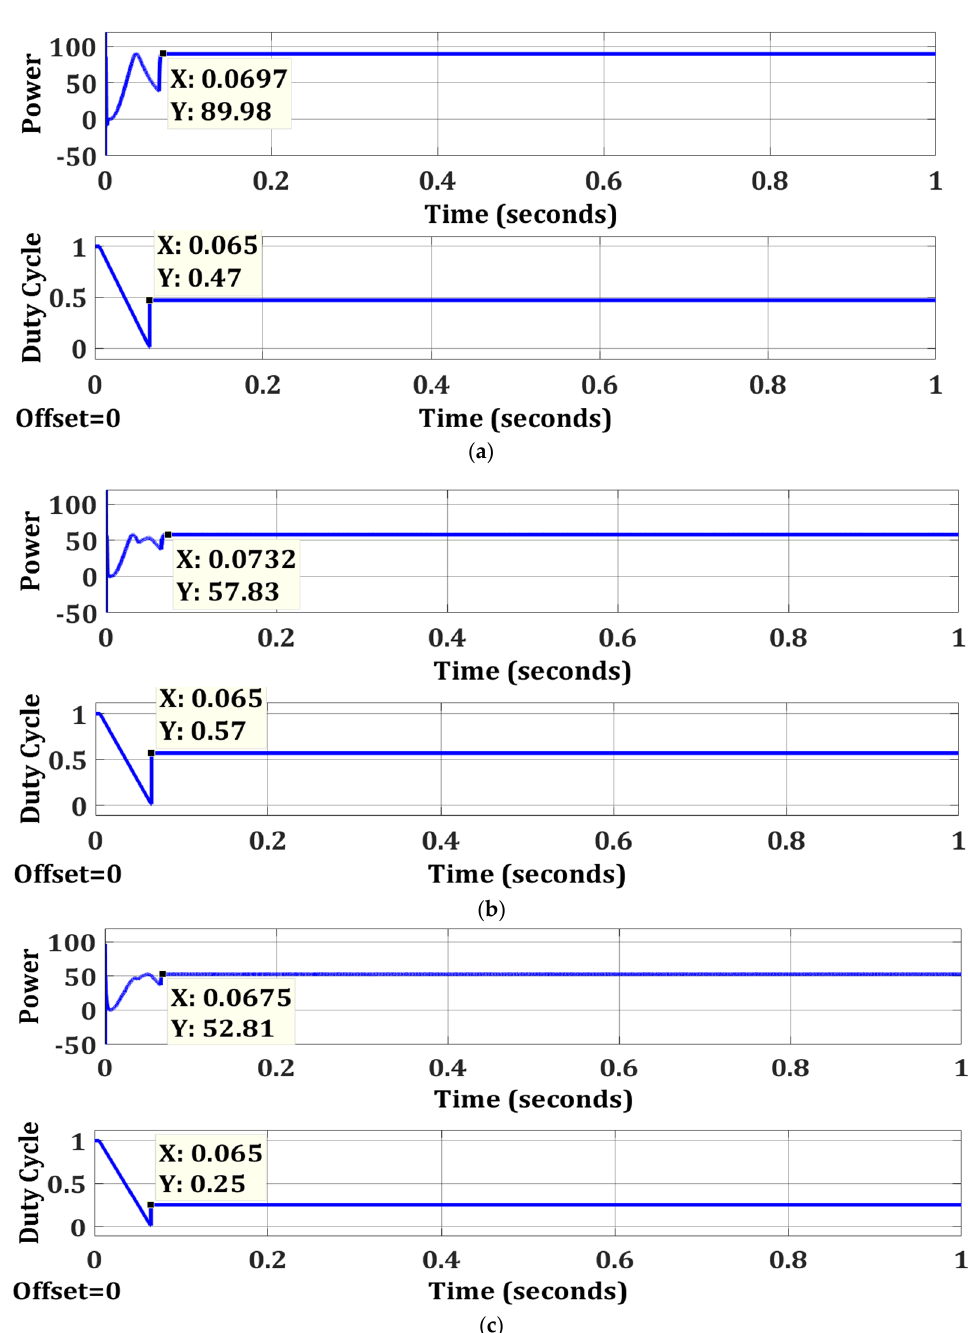
Figure 22. Simulation results for 3S PV system : ( a ) ten check algorithm for test case 1; ( b ) ten check algorithm for test case 2; ( c ) ten check algorithm for test case 3.